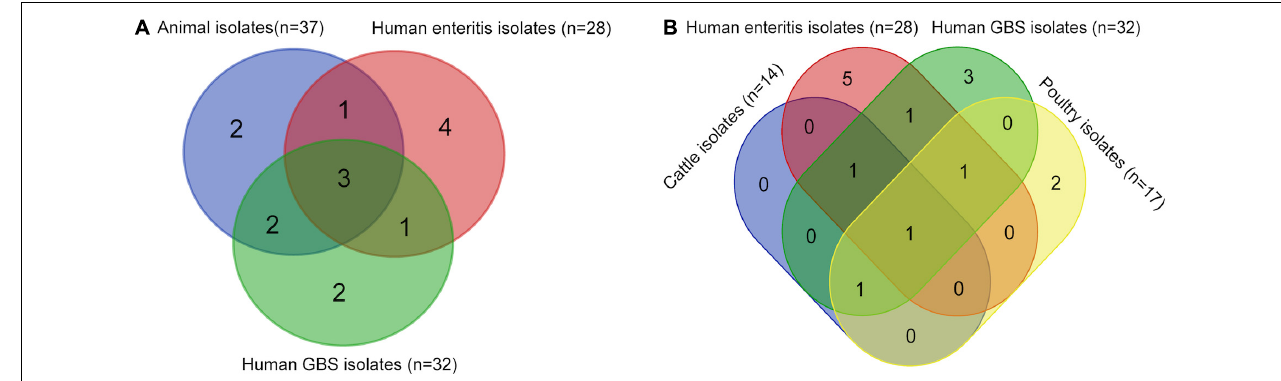
FIGURE 4 | Comparison of sequence types among Campylobacter jejuni isolates from different sources. These isolates include 37 animal isolates with disease associated serotypes, 28 enteritis isolates, and 32 GBS isolates from PubMLST. (A) Venn diagram shows the sequence types of isolates from GBS patients, enteritis patients, and animals. (B) Venn diagram shows the sequence types of isolates from GBS patients, enteritis patients, poultry, and